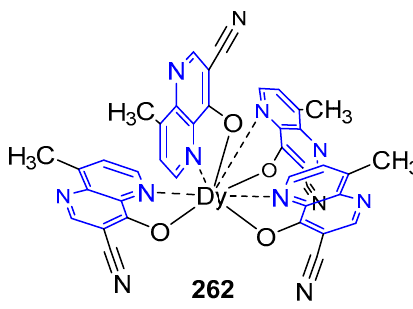
Figure 37. Dysprosium complexes as light emitters.